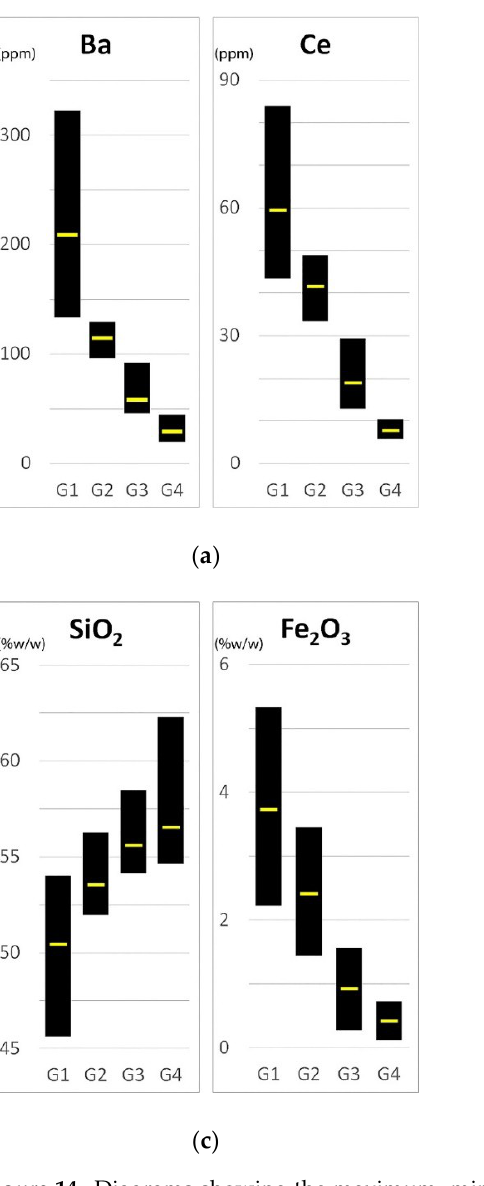
Figure 14. Diagrams showing the maximum, minimum and mean (yellow line) values of selected major and trace elements from the different cluster groups. The compositional ranges of the elements according to their geochemical evolution give rise to 4 associations of elements: ( a ) Association of elements concentrated mainly in G1, represented by Ba and Ce; ( b ) Association of elements distributed from G1 to G4 that are separated into two overlapping groups represented by MgO and Al 2 O 3 ; ( c ) Association of elements staggered from G1 to G4, represented by SiO 2 and Fe 2 O 3 ; ( d ) Association of elements that do not show defined trends, represented by Br and Cu.